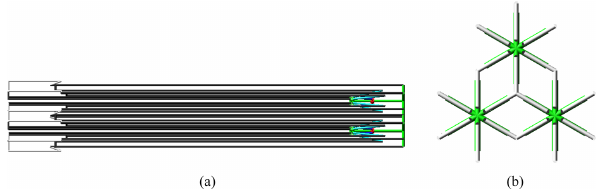
Figure 21. Folded state of deployable mechanism. (a) Side view. (b) Top view.